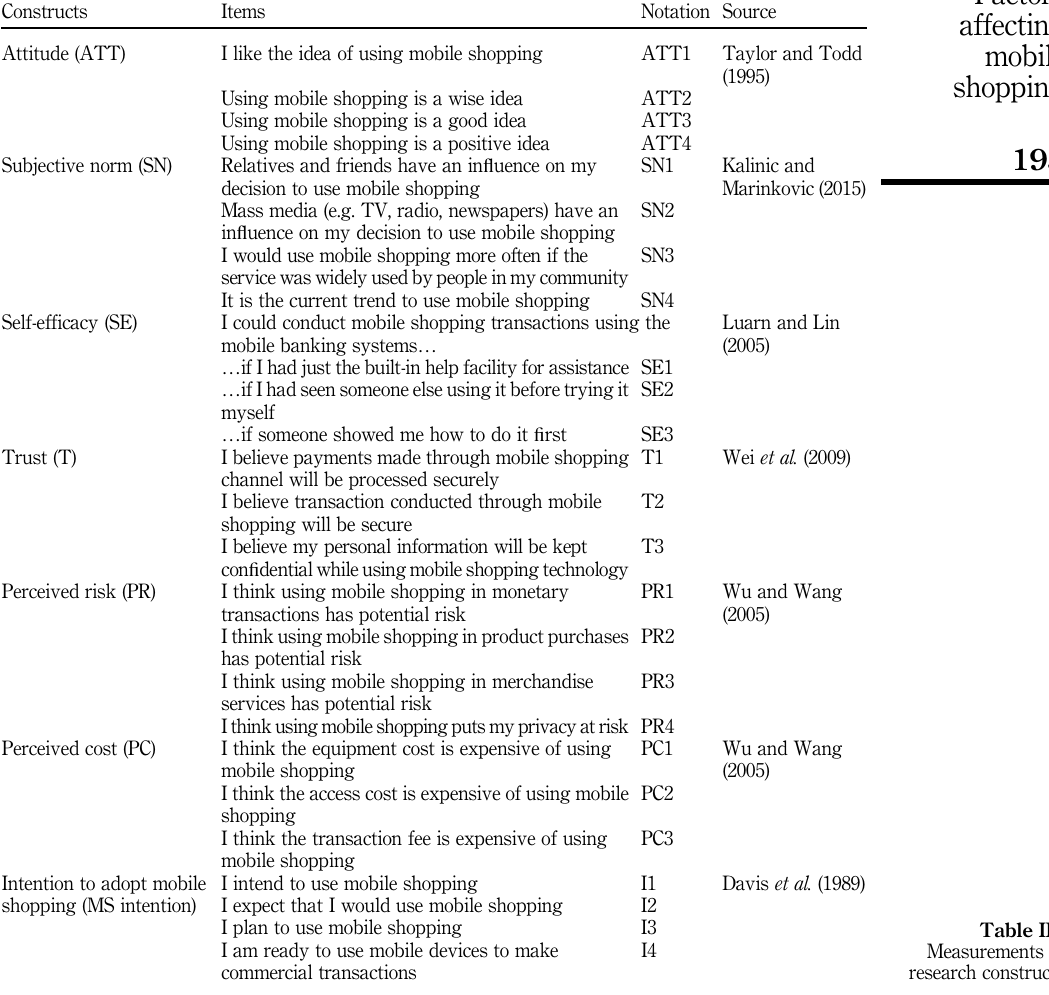
Table III. Measurements